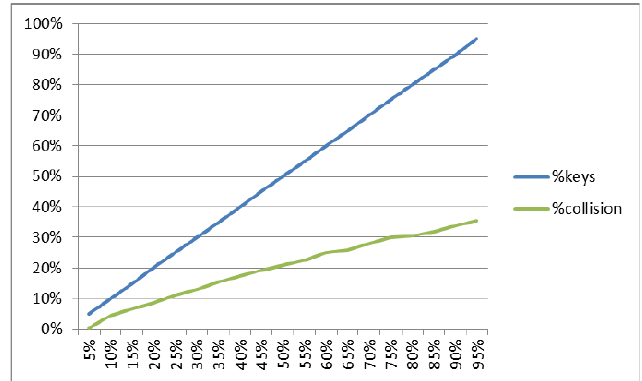
Fig. 4. %Collisions is roughly portioned to